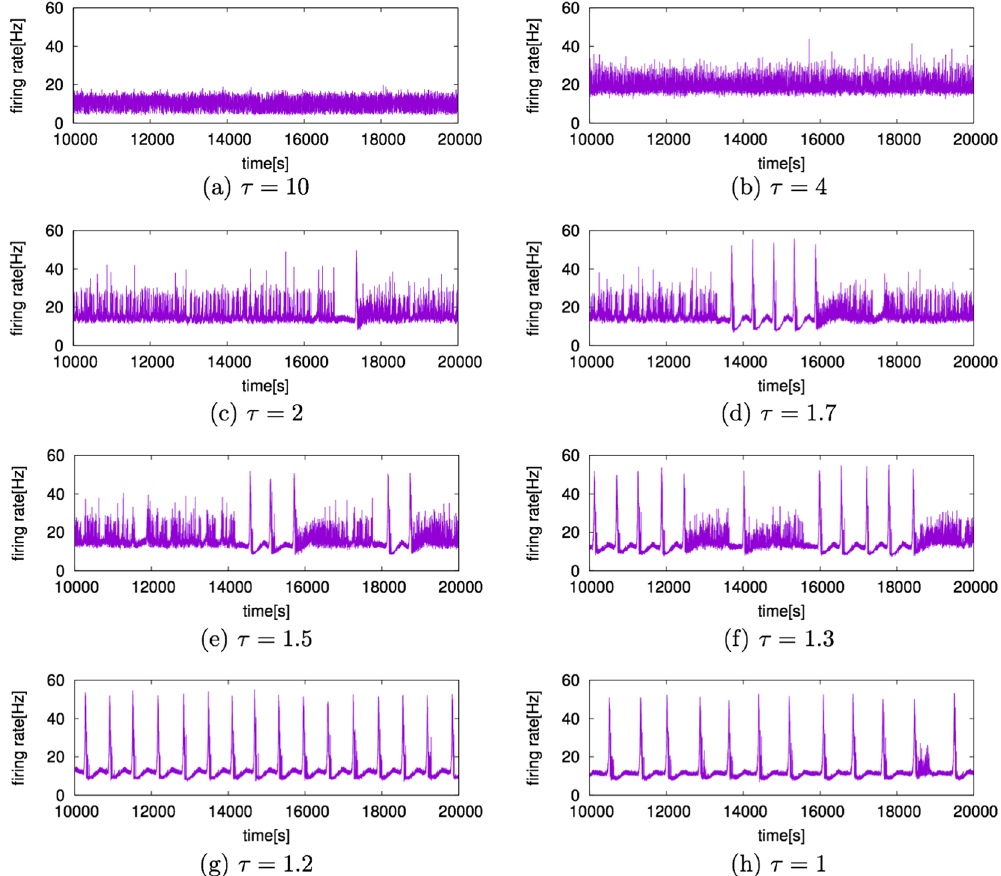
Figure 1. Temporal changes in firing rates. The horizontal axis is time [s] and the vertical axis is the firing rate [Hz]. When τ = 10, the firing rate oscillates with high frequency with an almost constant amplitude. When the values of τ become smaller, as in ( b ) and ( c ), the amplitudes of the firing rate become larger. When τ ≤ 1.7, as in ( d ), ( e ), and ( f ), the amplitudes change irregularly, exhibiting sudden increases in the firing rates. When τ takes a value close to unity, as shown in ( g ) and ( h ), the firing rate periodically repeats sudden increases and decreases with very slow frequency ( < 0.002